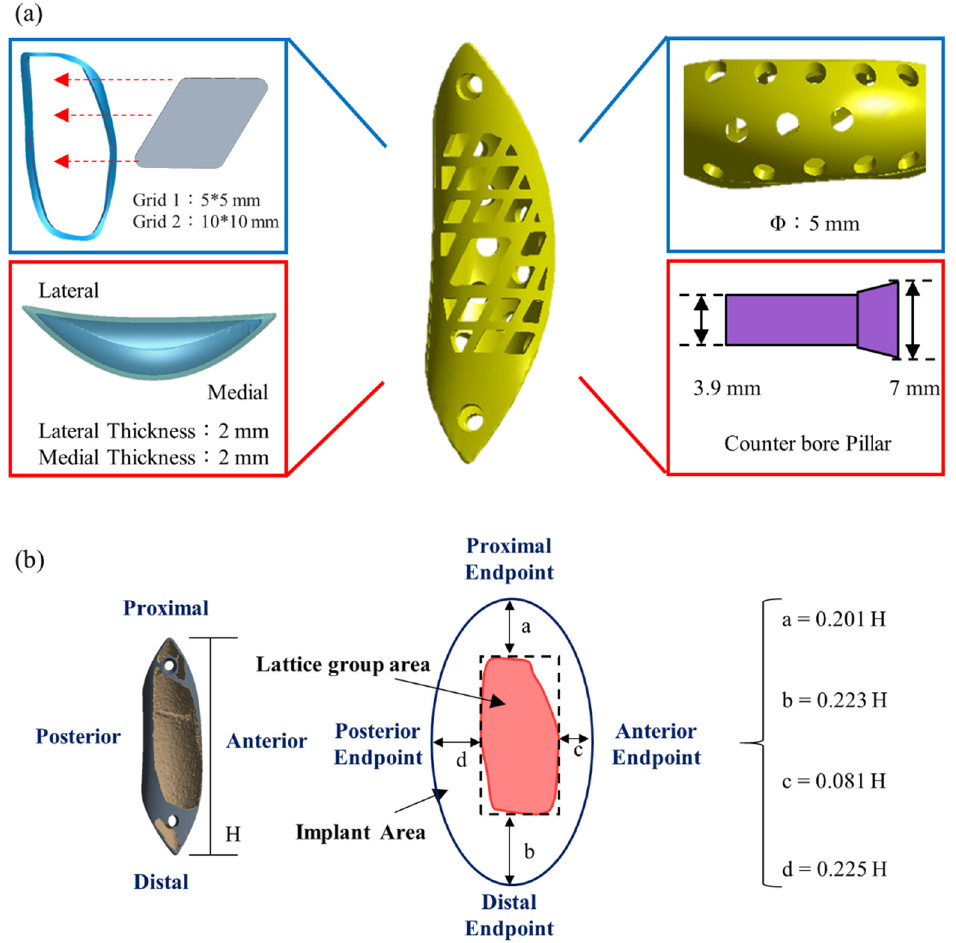
Figure 5. Features of the bone scaffold implant. ( a ) The outer surface was designed as a lattice structure to minimize stress and allow for filling with autologous or artificial bone; ( b ) The implant dimensions a, b, c, and d are reported relative to the implant length (Y/3) from the mesh area to the bone surface boundary.